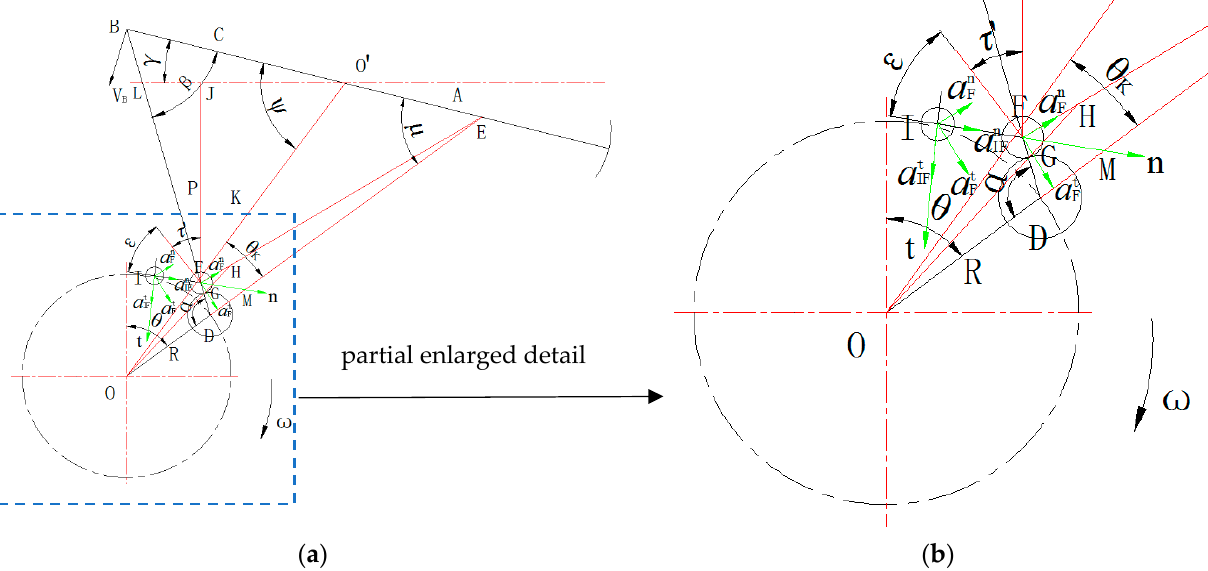
Figure 5. Acceleration analysis of secondary balance of the pumping unit after transformation: ( a ) complete analysis of the secondary balance acceleration; ( b ) partial enlarged analysis of the secondary balance acceleration.